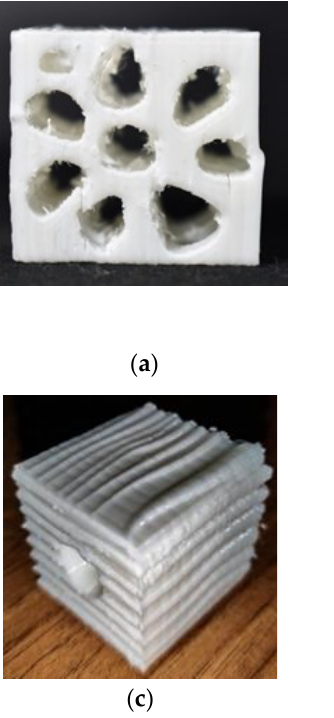
Figure 21. ( a ) Compressed Rudraksha model; ( b ) Failed Rudraksha model; ( c ) Horn mimic model.